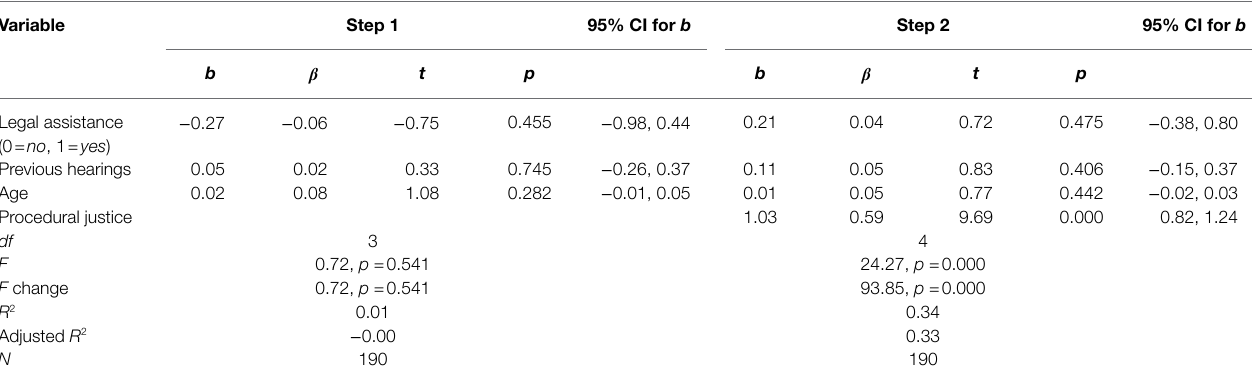
TABLE 4 | Outcome judgments regressed on procedural justice and relevant background variables.